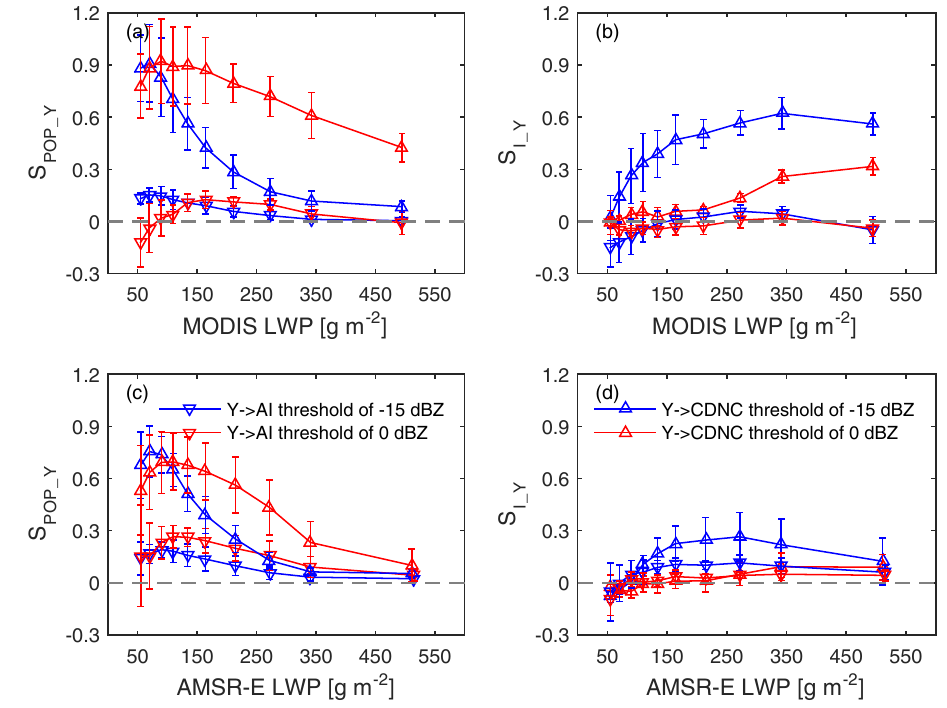
Figure 9. (a, c) S POP_Y and (b, d) S I_Y as a function of LWP. The subscript Y denotes different aerosol proxies corresponding to AI (downward triangles) and CDNC (upward triangles). The 2B-GEOPROF product is used here. Blue and red symbols represent − 15dBZ and 0dBZ thresholds, respectively. The top and bottom panels stand for MODIS and AMSR-E LWP,